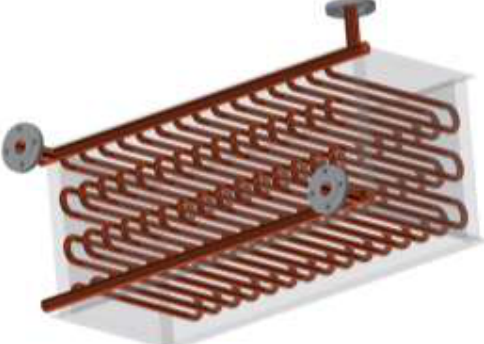
Fig. 4. Construction of copper coil registers for condenser.